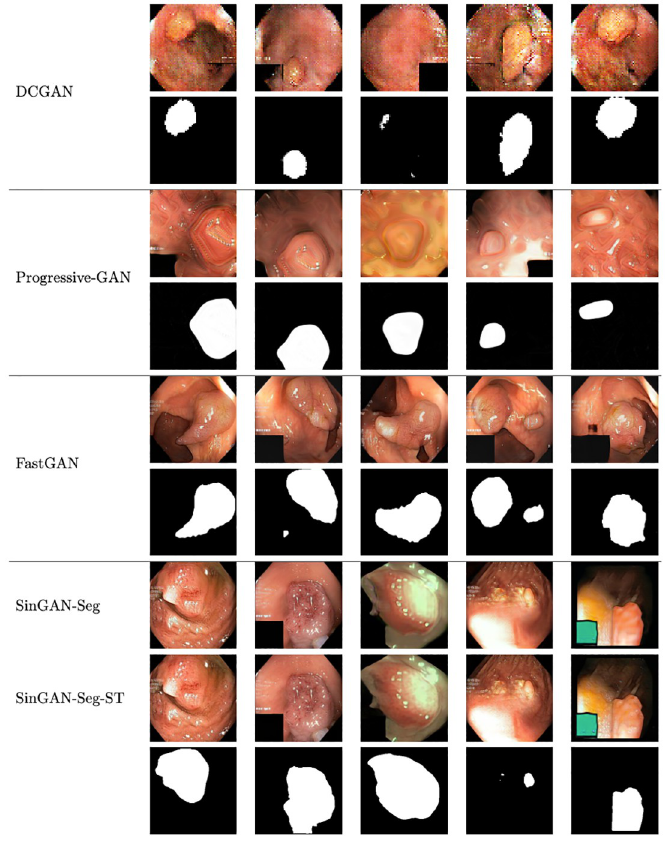
Fig 12. Sample images generated from different GAN architectures. SinGAN-Seg has two versions: one is without style transfer (SinGAN-Seg) and one is with style transfer (SinGAN-Seg-ST). The best ratio of content : style = 1: 1, 000 was used for transferring